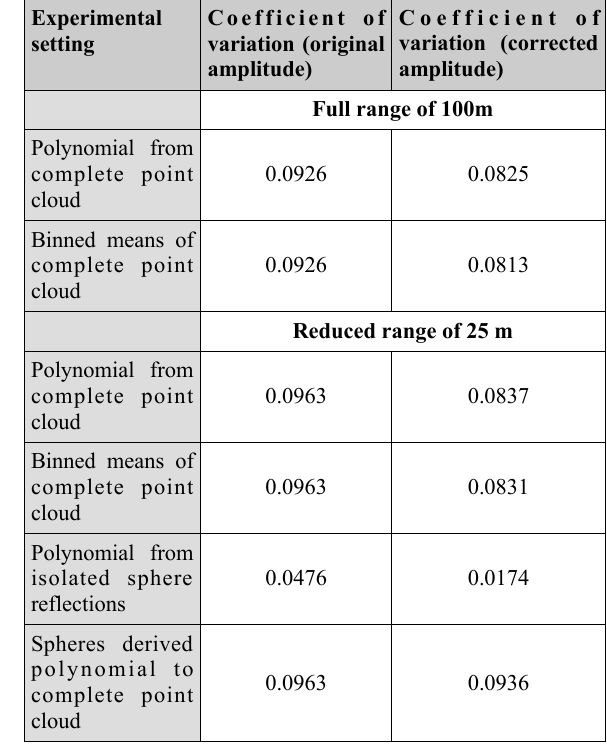
Table 1. Comparison of the coefficients of variation before and after correction of the amplitudes. The coefficients are listed for different experimental settings. The upper part of the table shows values for the full data range of 100 m and the lower part is limited to 25 m, which is the maximum distance of the spheres.